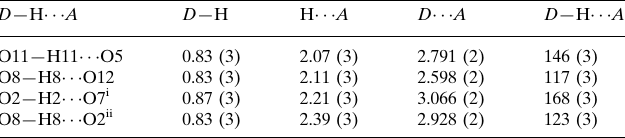
Hydrogen-bond geometry (A ˚ , (cid:5)